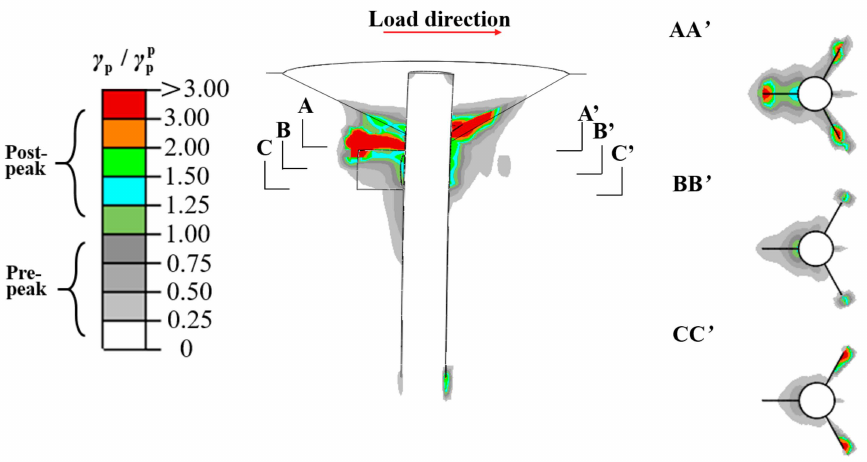
Figure 21. Distribution of plastic shear strain in the plane of symmetry of the winged monopile (WP3) with S/D = 1.5 at θ = 2 ◦